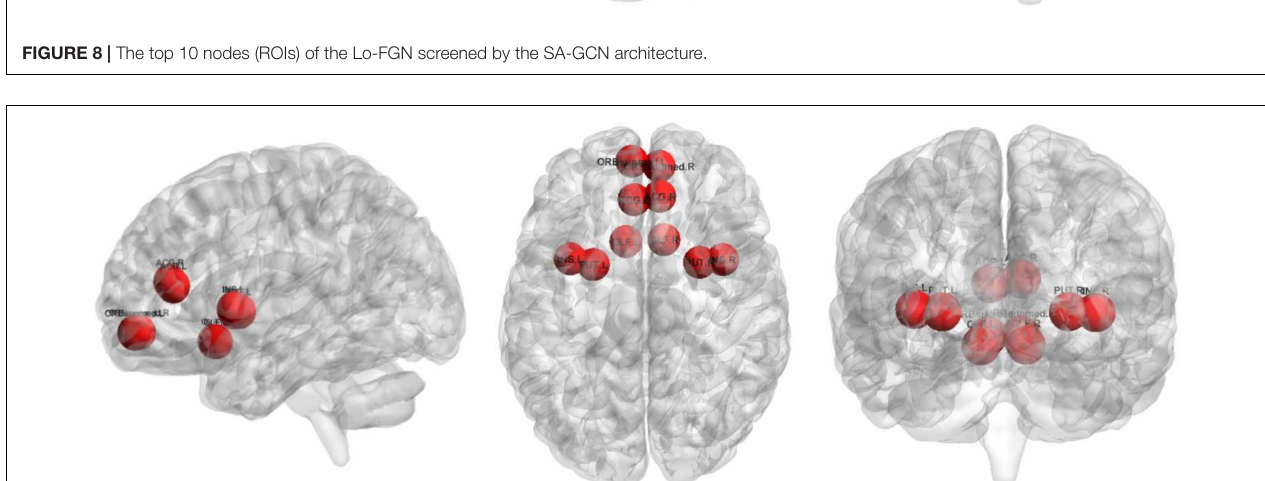
FIGURE 9 | The top 10 nodes (ROIs) of the Ho-FGN screened by the SA-GCN